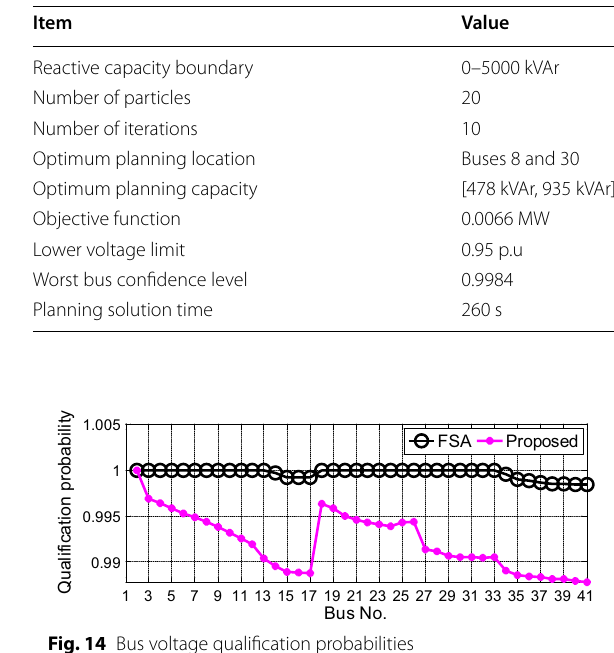
Table 11 Simulation results using theory in [17]